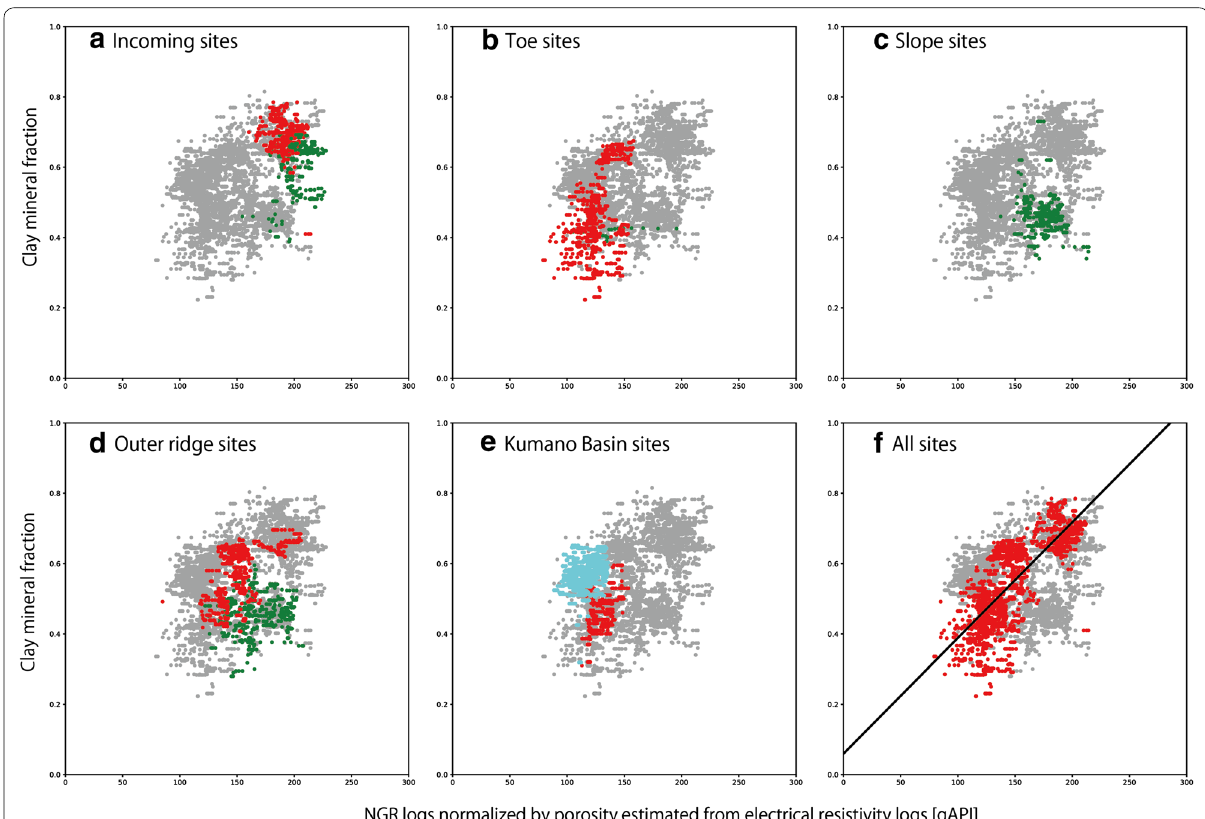
Fig. 7 Comparison between the NGR logs normalized using porosity estimated from the electrical resistivity logs and the clay mineral fractions. The panels show results from the a incoming sites, b toe sites, c slope sites, d outer ridge sites, e Kumano Basin sites, and f all sites combined. Color code (red, green, and light blue) for dots in Fig. 7 is common to that used for lithological units in Figs. 2, 3, 4, 5, 6. Red dots represent the standard sediments, for which the empirical conversion function is established. Green dots represent the upper part of USB sediments or the slope apron facies younger than 1.5 Ma, which shows higher normalized NGR log values than the standard sediments possibly due to volcanic ashes included in sediments. Light blue dots are the inner prism sediment below the Kumano Basin, which shows lower NGR log values than the standard sediments possibly due to poor hole condition. Grey dots indicate all